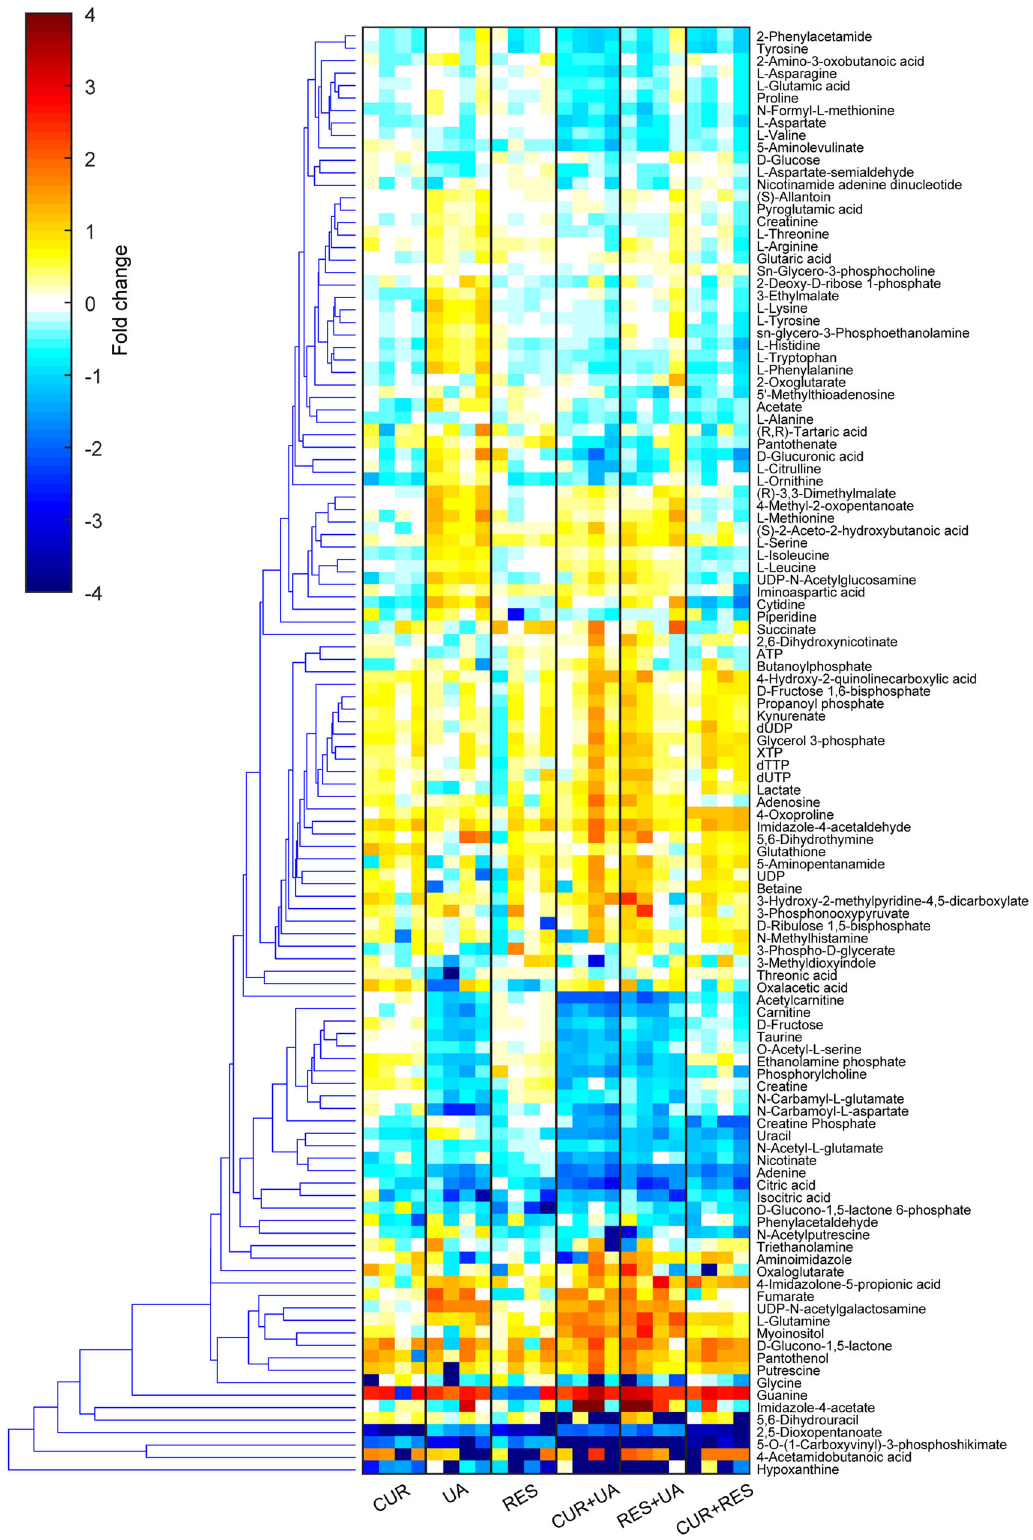
Fig. 3 Metabolite level modulation in HMVP2 cells following treatment with CUR, UA, RES or their combinations. HMVP2 cells were treated for 12 h with 20 μ M CUR, UA, RES or their combinations of two compounds. Fold change (compared to untreated samples) of polar intracellular metabolite levels measured by UHPLC-MS and MRS. Hierarchical clustering was performed using the Euclidean distance and average linkage clustering methods on the intracellular levels (normalized to control) of all the identi fi ed